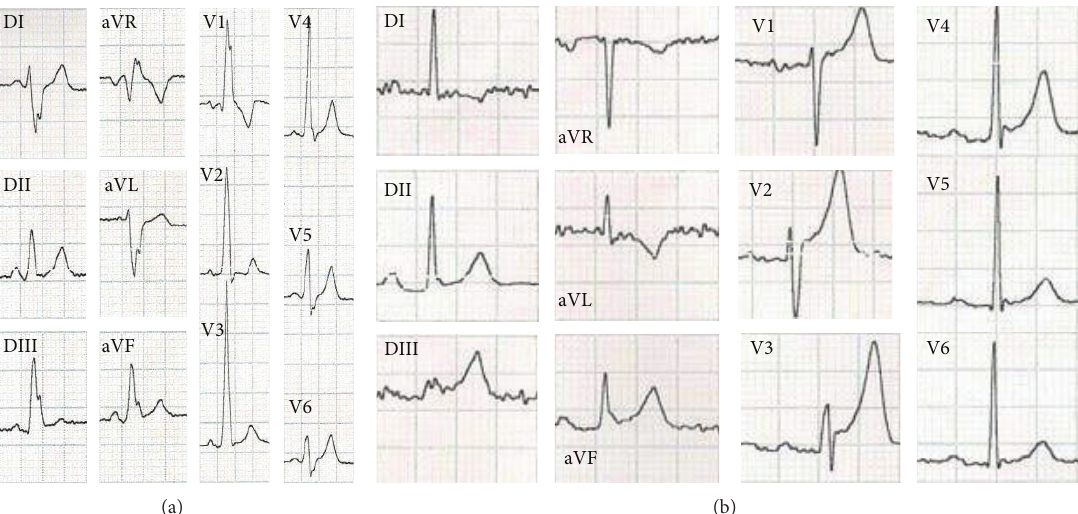
Figure 1: (a) Regular sinus rhythm at 70 beats per minute, a wide QRS and PR interval was 120ms (b) post ablation we show a normal QRS.